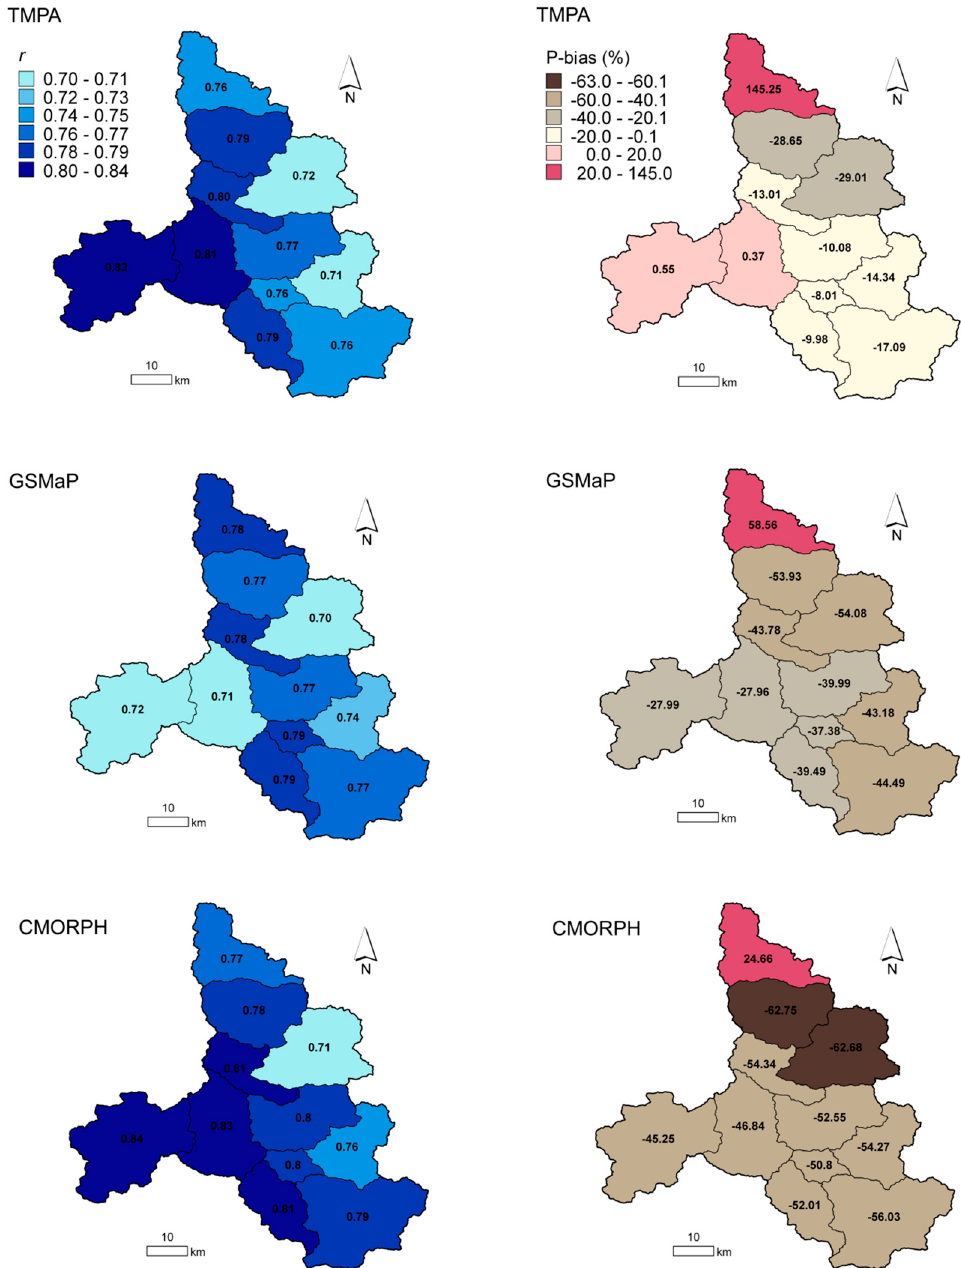
Figure 4. Spatial variability of correlations averaged over 2002–2009 between basin-averaged precipitation from TMPAv6, TMPAv7, GSMaP, CMORPH and gauged estimates over the Soyang dam basin.